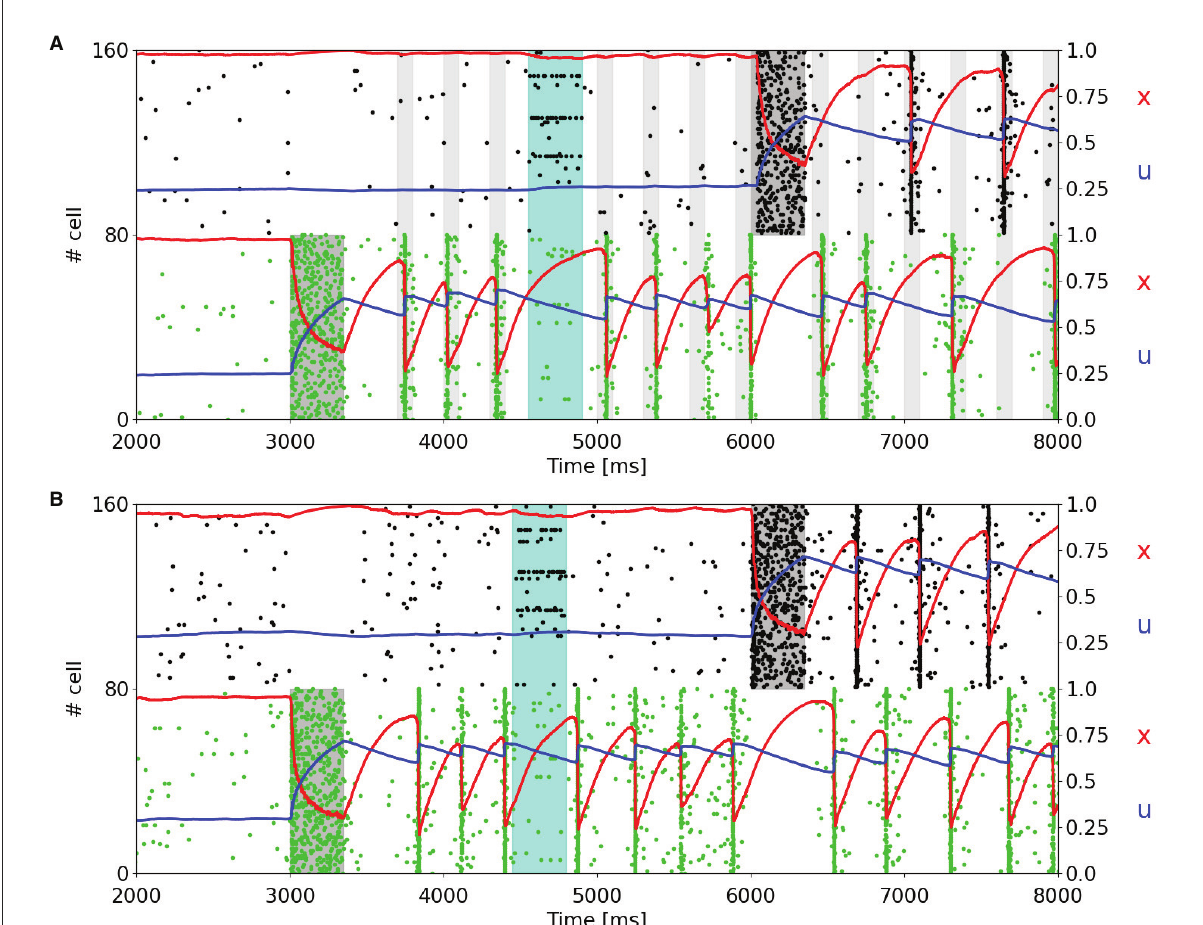
FIGURE3 Raster plots of a subset of neurons of two targeted selective populations when two items are loaded into the network. An additional noise (cyan shading), which targets 15% of the excitatory neurons, is injected to test the network’s robustness. (A) Network showing a single stable activity state injected with a periodic readout signal targeting all the excitatory neurons. After the second memory is loaded into the network, the populations show alternating population spikes. (B) Network in the bi-stable regime showing synchronous spiking activity. Here, the network does not receive the periodic input since the synchronous activity autonomously shows up after the item loading. After the second memory is loaded, the population spikes of the stimulated selective populations alternate, refreshing the synaptic variables in order to maintain the synchronous spiking